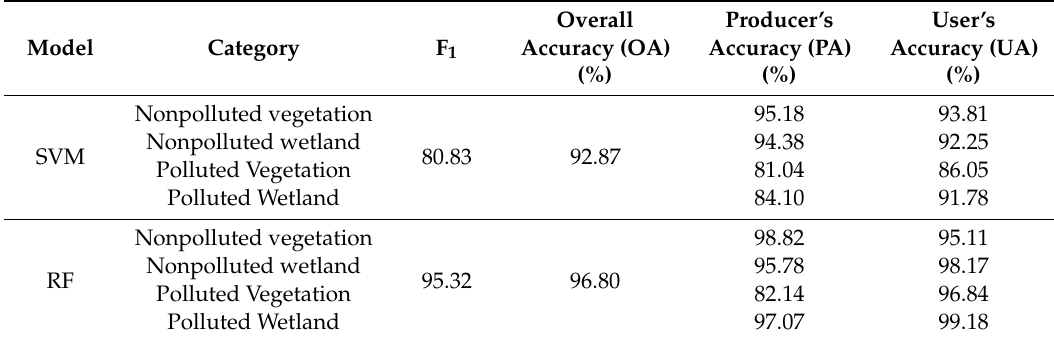
Table 6. Accuracy matrix value for SVM and RF for the pollution and other categories classification for the study area (Kota-Tinggi).